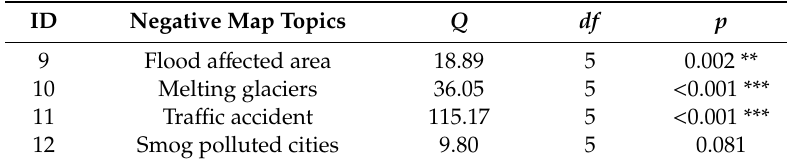
Table 5. Results of the Durbin-Skillings-Mack test for negative map topics.